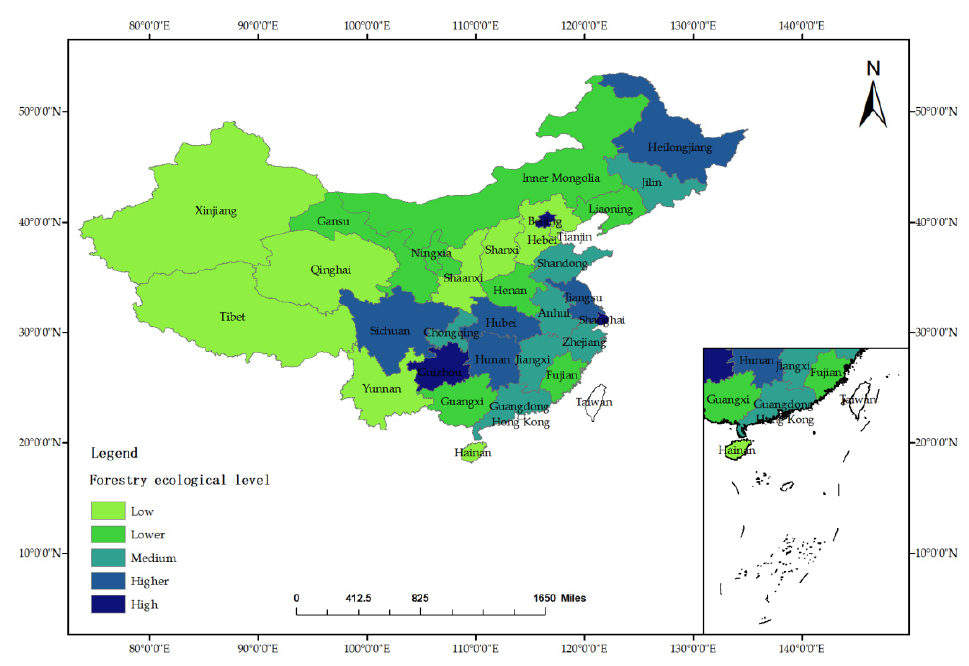
Figure 6. Distribution map of the ecological development appraisement value in 2018.